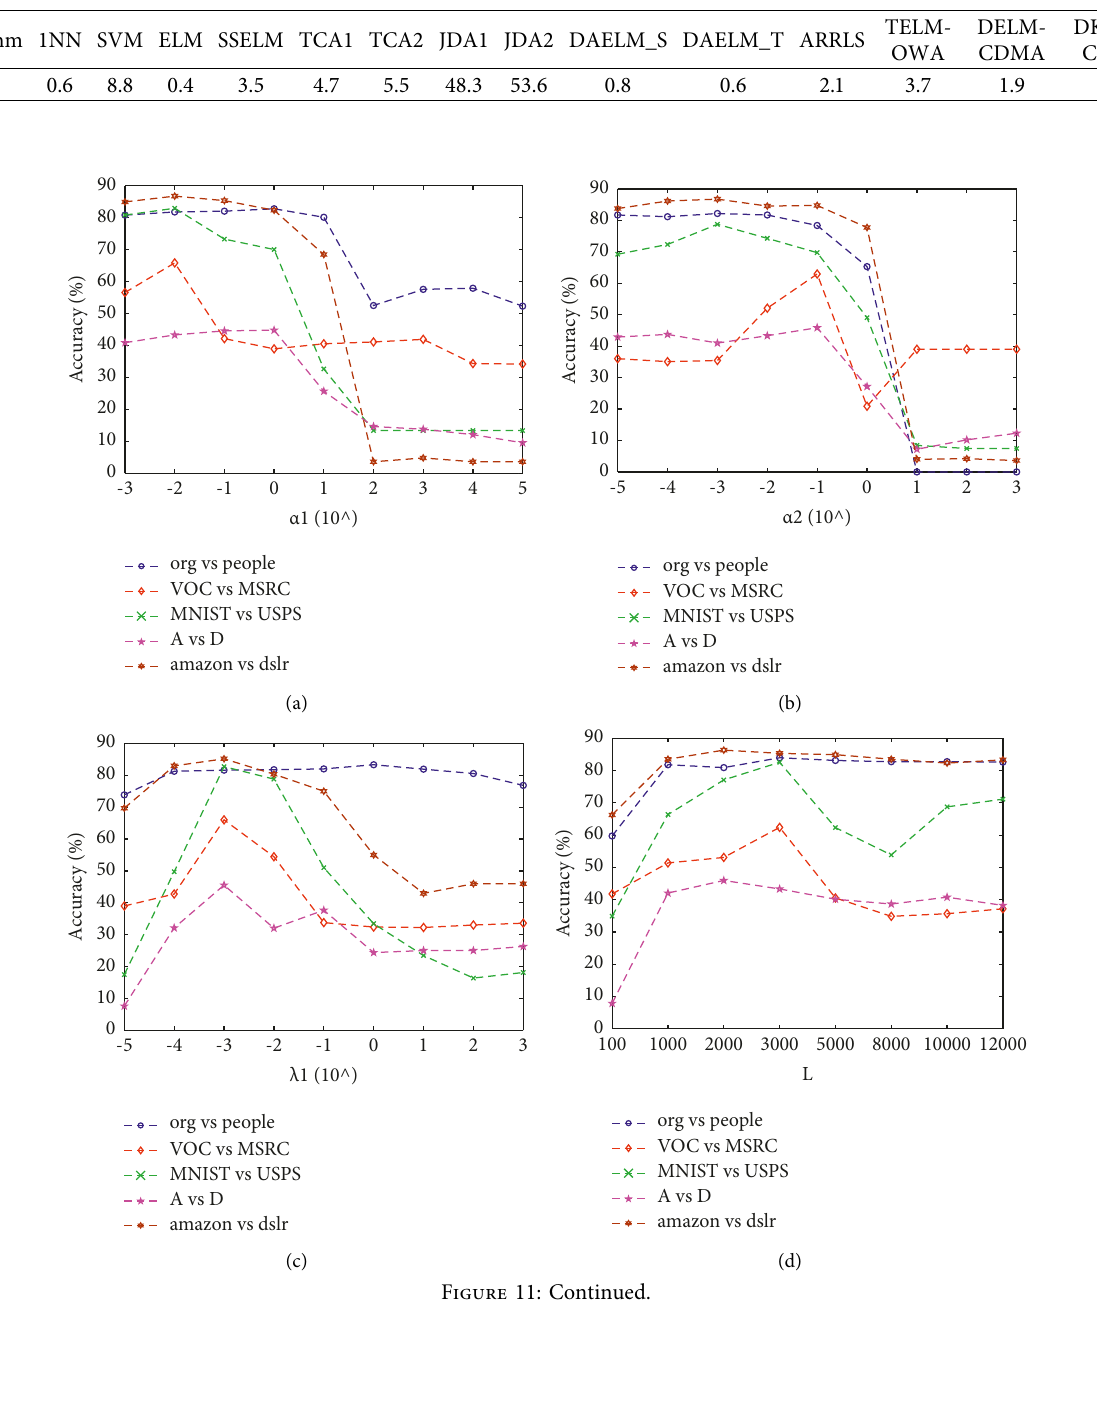
Table 6: Comparison of running time on MNIST ⟶